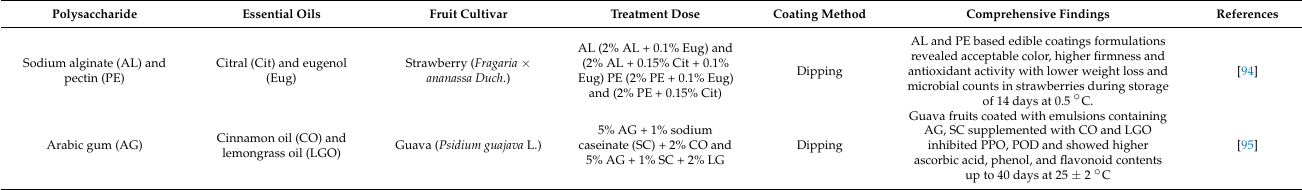
Table 2. Polysaccharides combined with essential oils for the quality preservation of fresh fruits during postharvest